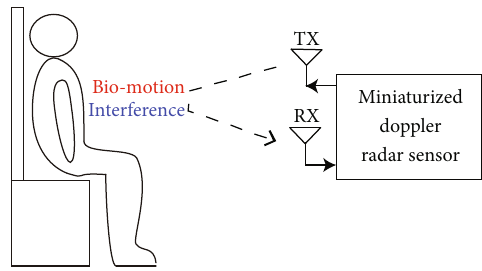
Figure 1: A classical radar system for biosignal detection including antennas, RF circuits to transmit and receive signals, and a signal processing unit. Interference is inventible during the